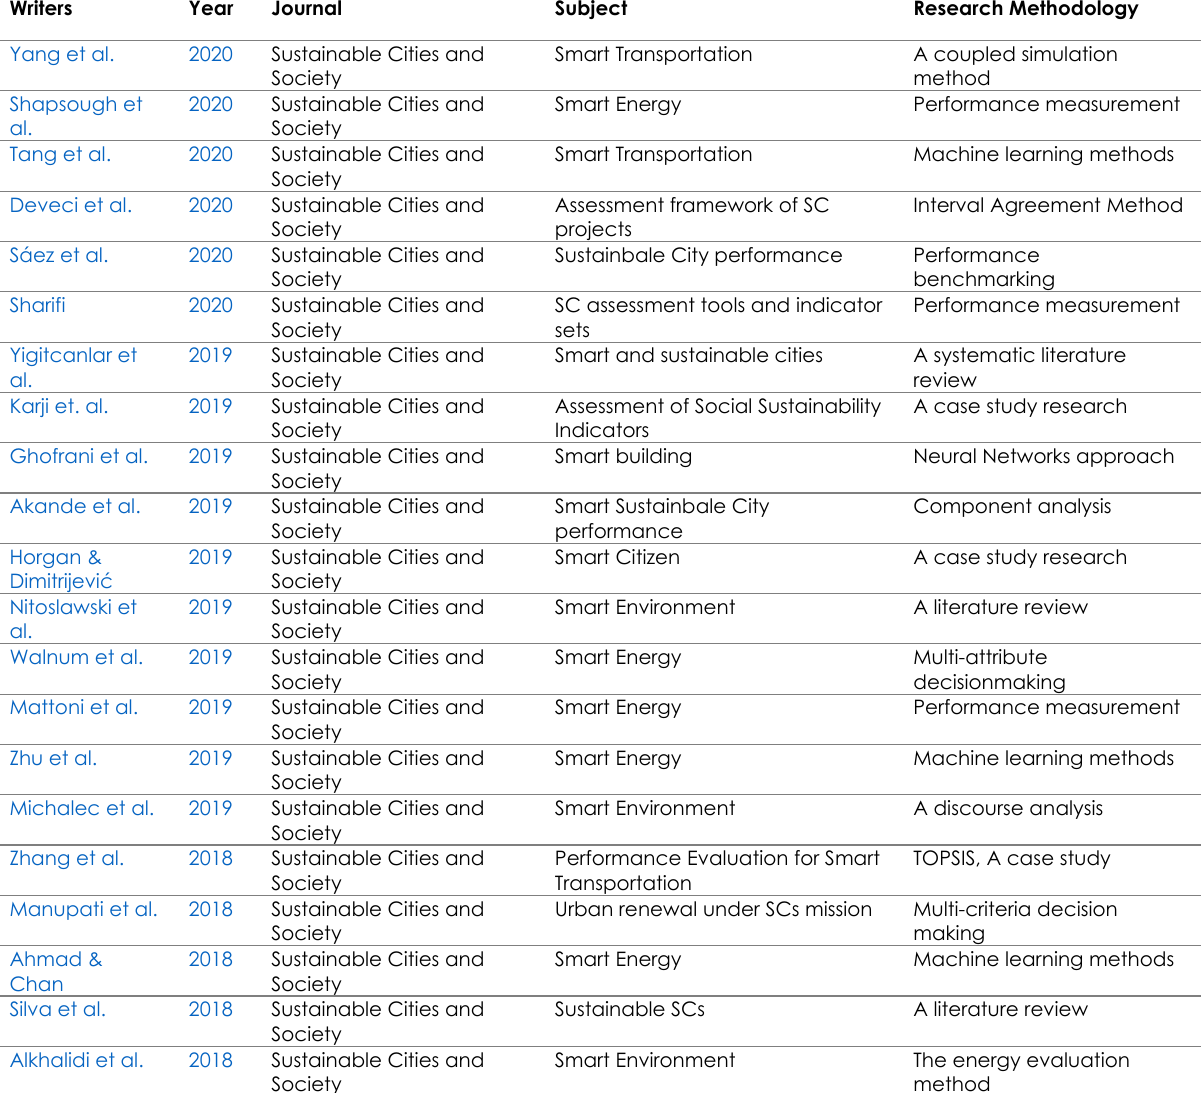
Table 2. Papers associated with KPIs of Smart City that has been published in Urban Literature from 2017 to 2020